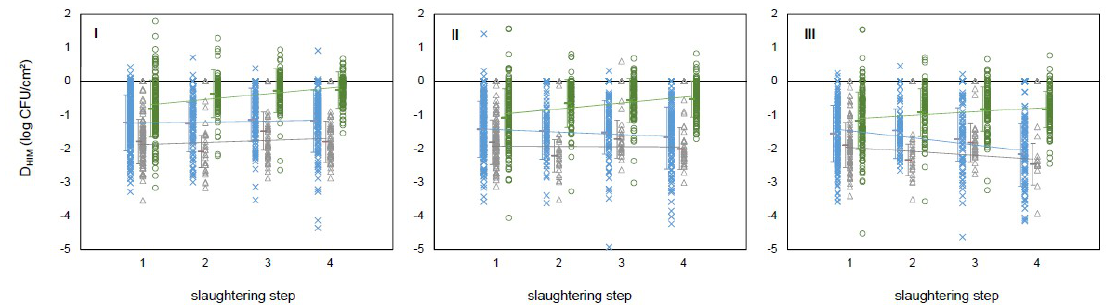
Figure 2. Differences between the microbial counts (log CFU/cm 2 ) of MA and a given hygiene indicator microorganism (D HIM ; I: Enterobacteriaceae; II: Total coliforms; and III: Escherichia coli ) as a function of the slaughtering step (step 1: Hide after bleeding; step 2: Carcass after hide removal; step 3: Carcass after evisceration; and step 4: Carcass after end washing), and the state of sample collection (blue cross: MG; gray triangle: PR; green circle: RS). The slopes are state-dependent and significantly different from zero ( p < 0.05) while the error around the linear trend can well be approximated by the normal distribution, with fairly constant deviation (see the error bars around the respective averages).